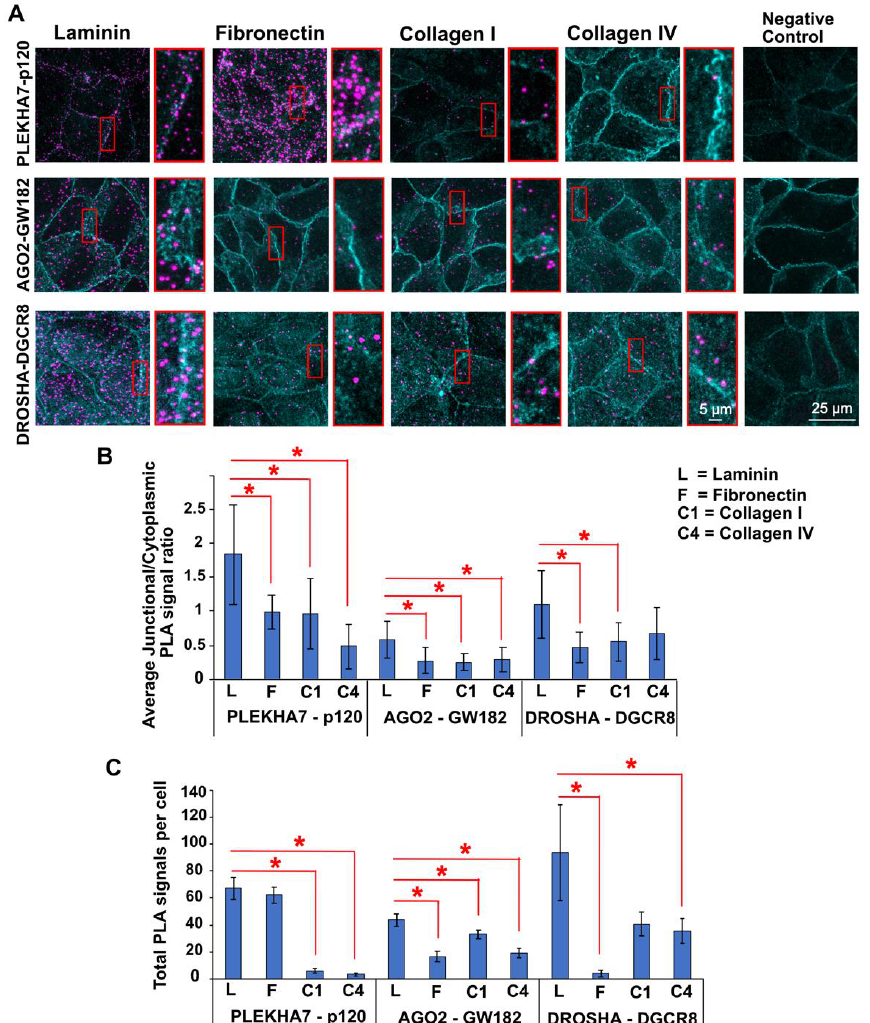
Figure 6. ( A ) Representative images of proximity ligation assay (PLA; magenta) for PLEKHA7-p120, AGO2-GW182, and DROSHA-DGCR8 of Caco2 colon epithelial cells plated on laminin, fibronectin, collagen I, and collagen IV, co-stained by immunofluorescence with E-cadherin (cyan). ( B ) Average junctional/cytoplasmic (for PLEKHA7-p120, AGO2-GW182) or junctional/(cytoplasmic + nucleus) (DROSHA-DGCR8) ratios of PLA signals. ( C ) Total PLA signals per cell count. The data were analyzed using a student t -test, where p < 0.05 and 9 ≤ n ≤ 12. (see also Methods, Section 2.5). Statistical significance of p < 0.05 is indicated by asterisks (*). Selected insets indicated in red boxes are shown enlarged on the right of each image